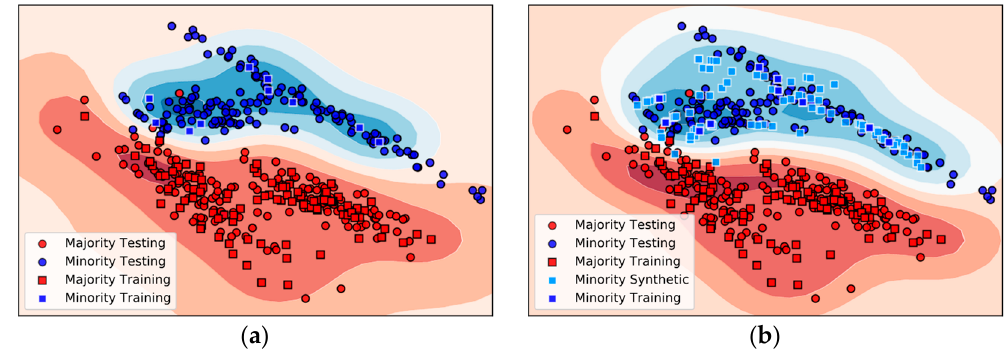
Figure 2. ( a ) Shows the binary support vector classifier induced over the imbalanced training set; ( b ) Shows the illustration of classifier produced by using SWIM.